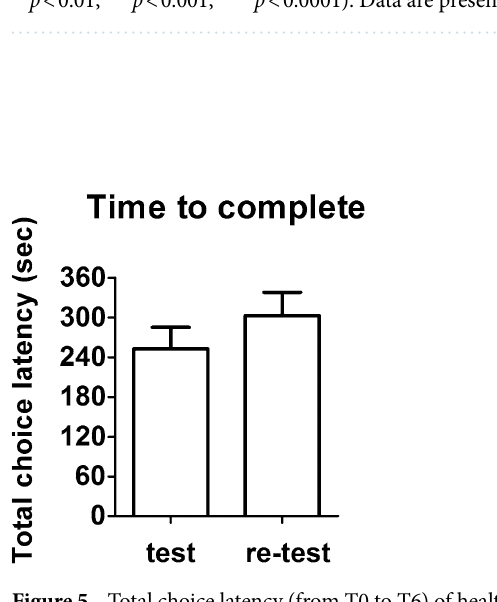
Figure 4. Choice latency of healthy wild-type mice in the re-test session of spontaneous alternation T-maze (intra-session effect of repetition). A significant increase of choice latency across trials of the re-test session was found (F 6,114 = 10.821, p < 0.0001). Asterisks highlight significant differences versus sample trial latency (* p < 0.05, ** p < 0.01, *** p < 0.001, **** p < 0.0001). Data are presented as mean ± SEM (n = 20).